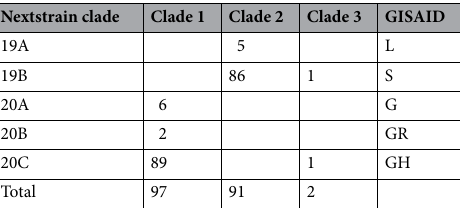
Table 4. Correspondence of Clade 1 and Clade 2 of current cohort to Nextrain and GISAID clades.